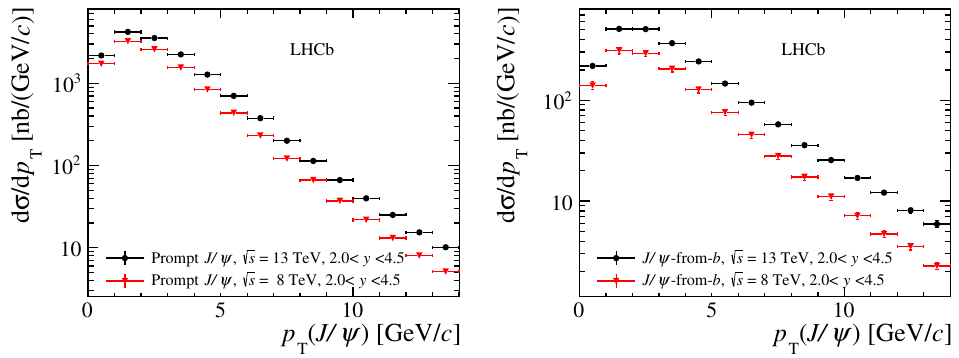
Figure 5 . Di(cid:11)erential cross-sections as a function of p T integrated over y for (left) prompt J= and (right) J= -from- b mesons.